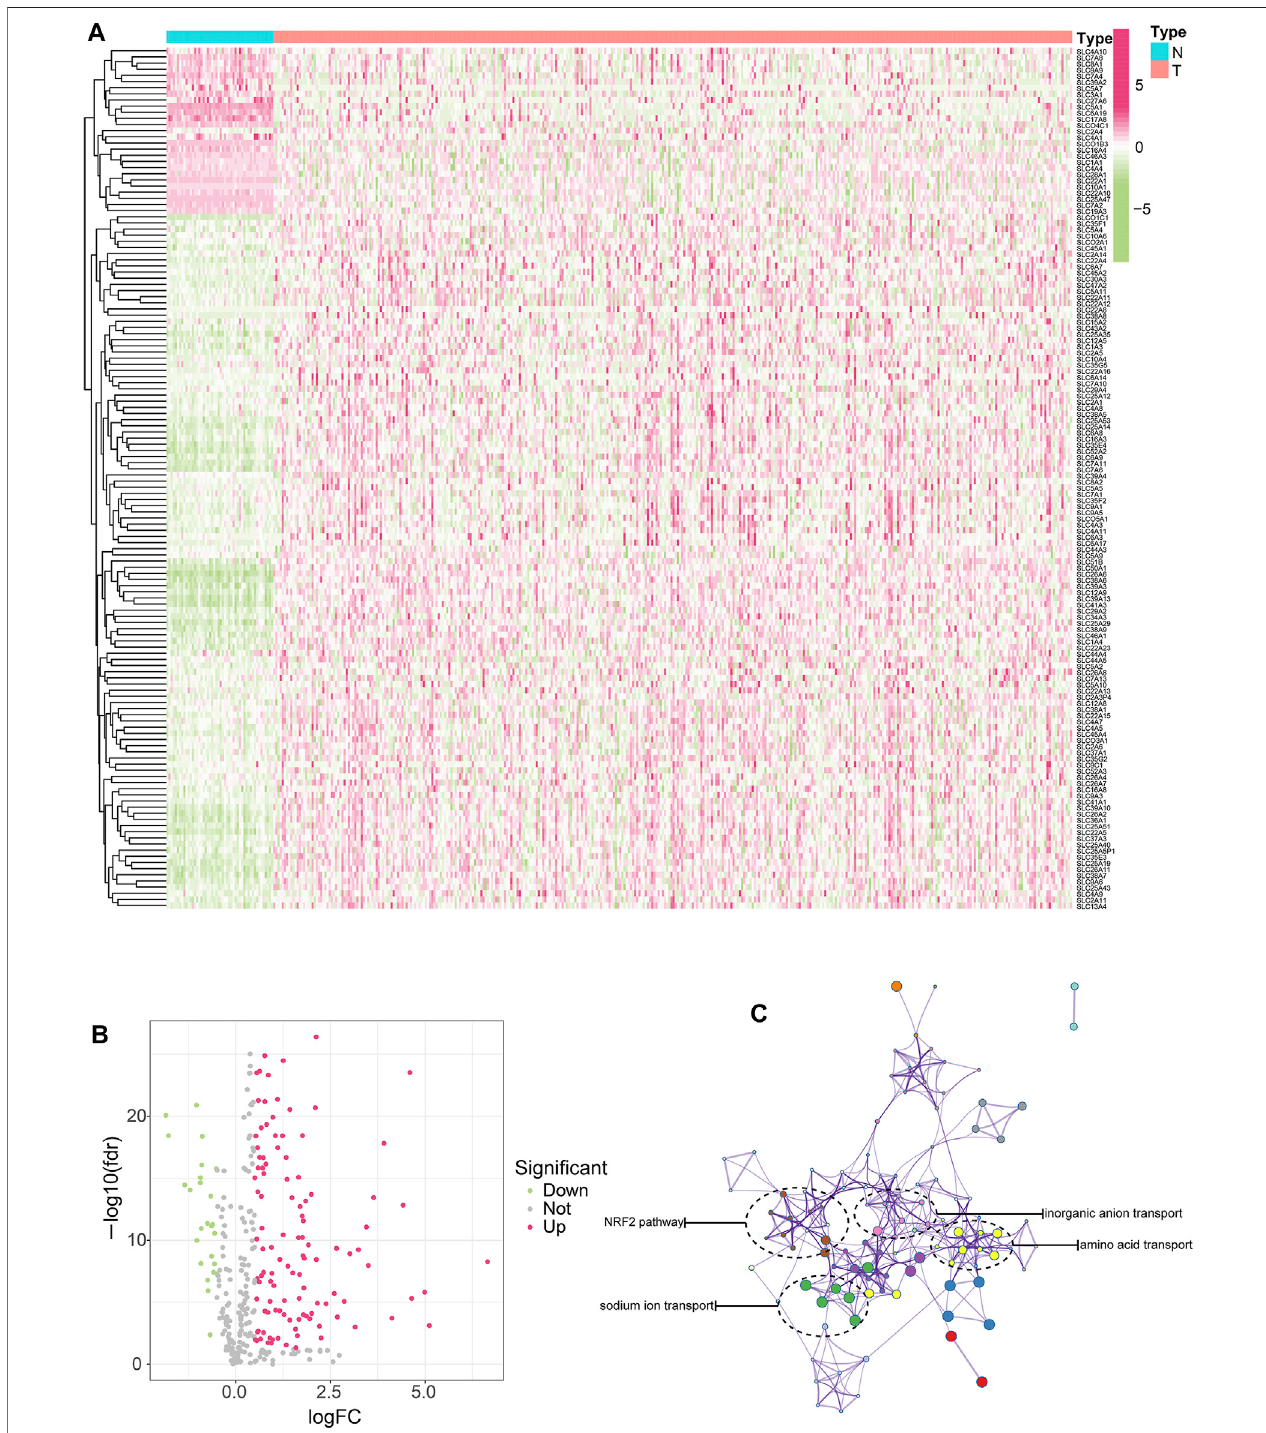
FIGURE 1 | Screening of SLC genes with differential expression and prognostic value in HCC. (A) SLC genes differentially expressed between HCC and normal tissueswereshowninheatmap.Redrepresentshighexpression,greenrepresentslowexpression,andthedarkerthecolor,themoresigni fi cantthedifference. (B) SLC genes differentially expressed between HCC and normal tissues were shown in volcano map. (C) The interaction network of differentially expressed SLC genes and the enrichment of functions and pathways.